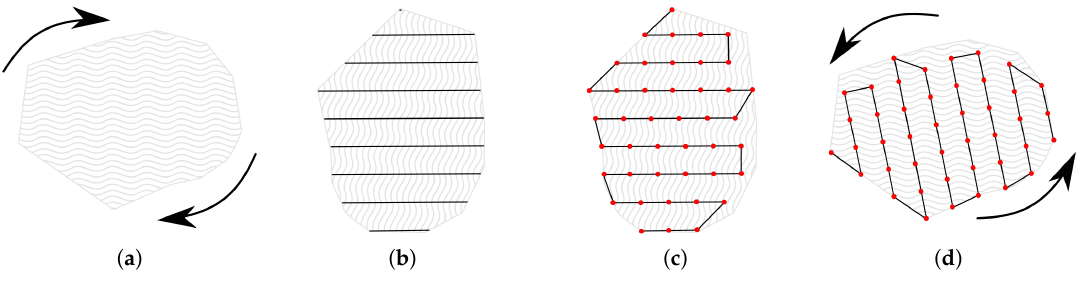
Figure 5. Survey path. ( a ) A region of interest is defined P and then rotated to be parallel to the X axis; ( b ) P is segmented in sections with an d distance; ( c ) Every line segment is subdivided in smaller d size segments and the visiting sequence is defined. Every survey visit point is denoted in red; ( d ) The final path is then rotated back to the desired angle.